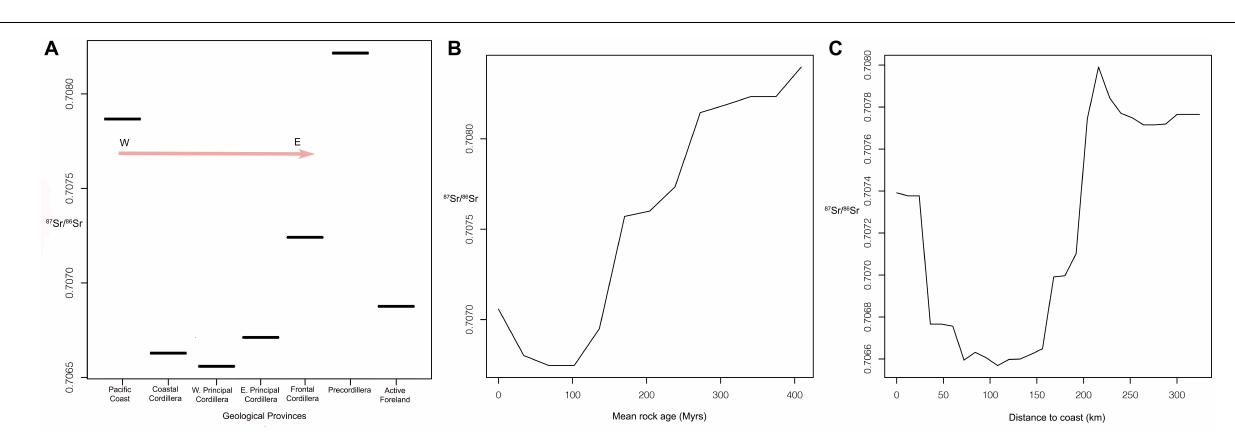
Frontiers in Ecology and Evolution |